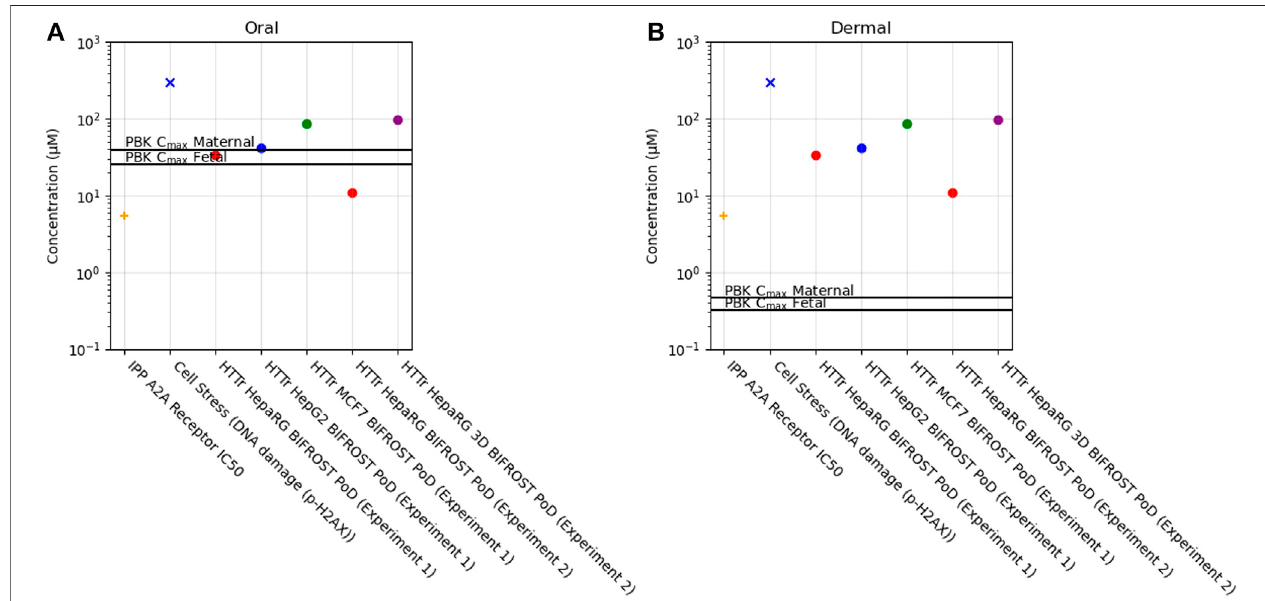
FIGURE 10 | Bioactivity Exposure Ratio of Caffeine for the oral (A) and dermal (B) exposure scenarios, comparing the IPP, CSP and Httr PoDs with maternal and foetal C max